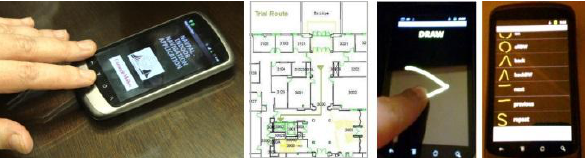
Figure 1: Initial prototype of NavPal dynamic guidance tool implemented on a